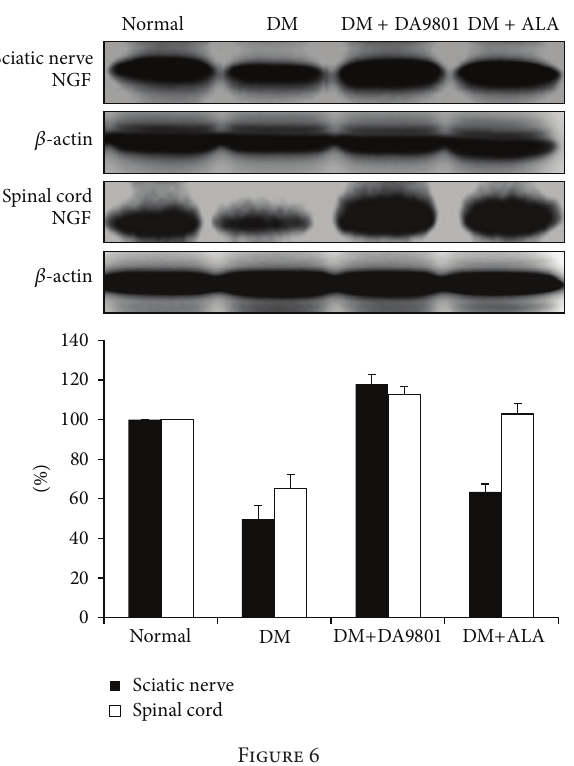
long-term diabetes, can become unresponsive to sensory stimuli due to generalized cachexia rather than something related to neuronal degeneration or